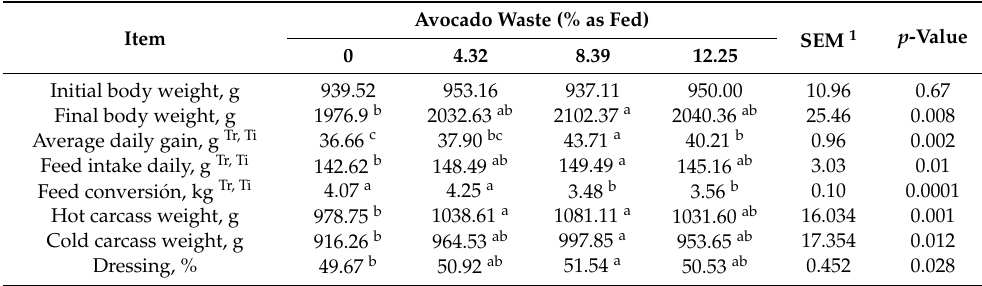
Table 2. Growth performances and carcass traits of fattening rabbits fed diets with different levels of avocado waste.